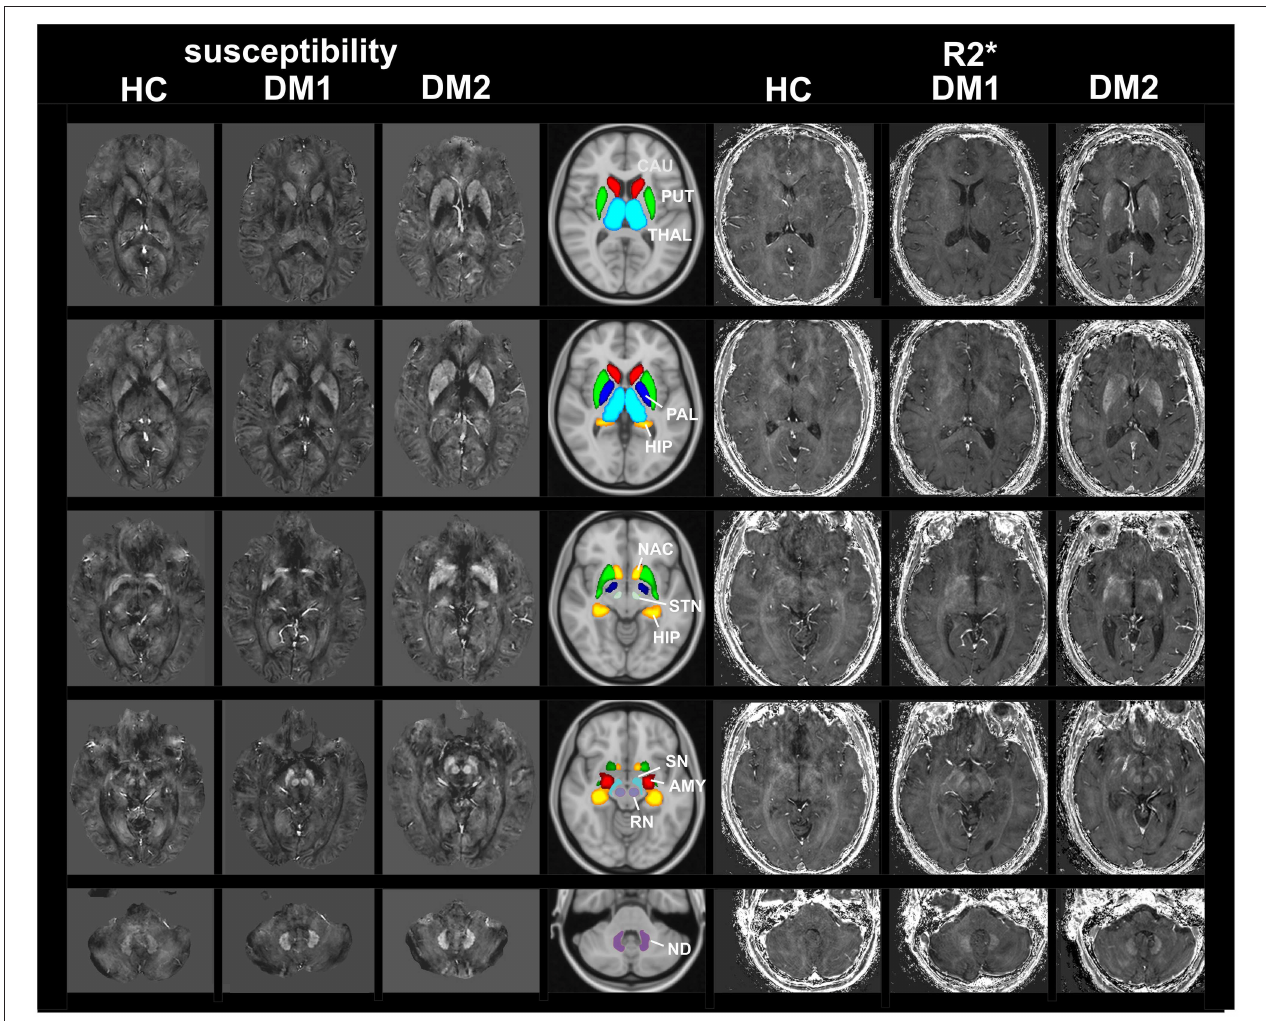
FIGURE 1 | MRI based imaging techniques of the brain. Examples of susceptibility maps (three left columns) and R2* maps (three right columns) illustrating marked disease and age related alterations in DGM nuclei in a DM1 patient (age 50 years, female, disease duration 8 years) and a DM2 (age: 57 years, female, disease duration 8 years) patient compared to a healthy control (age: 20 years, female). The middle column depicts the locations of the 11 investigated DGM structures as colored overlays on a standard T1 template. Major bilateral signal elevations in the patients compared to the HC can be seen in the caudate, putamen, accumbens and in the red nucleus and dentate nucleus. THAL, thalamus; CAU, caudate; PUT, putamen; PAL, pallidum; HIP, hippocampus; AMY, amygdala; NAC, accumbens; SN, substantia nigra; RN, red nucleus; STN, subthalamic nucleus; ND, dentate